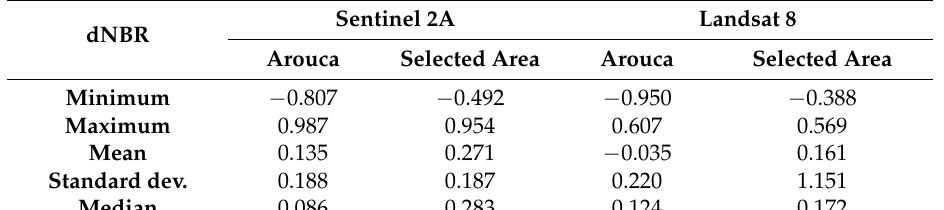
Table 5. dNBR statistical analysis for the entire Arouca municipality and the selected area, considering both Sentinel 2A and Landsat 8 data.